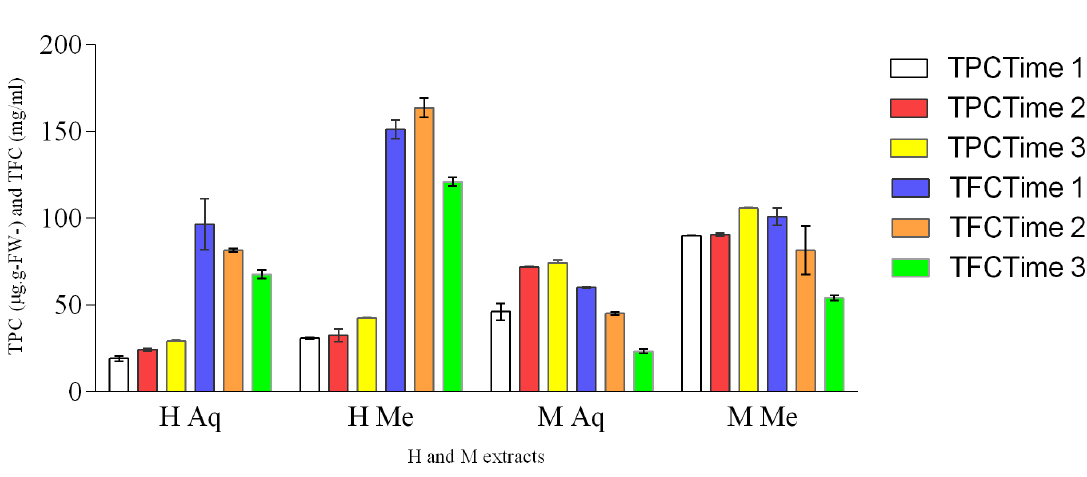
Fig. 4: Comparison of Aq and Me from 12 extracts in TPC and TFC, samples